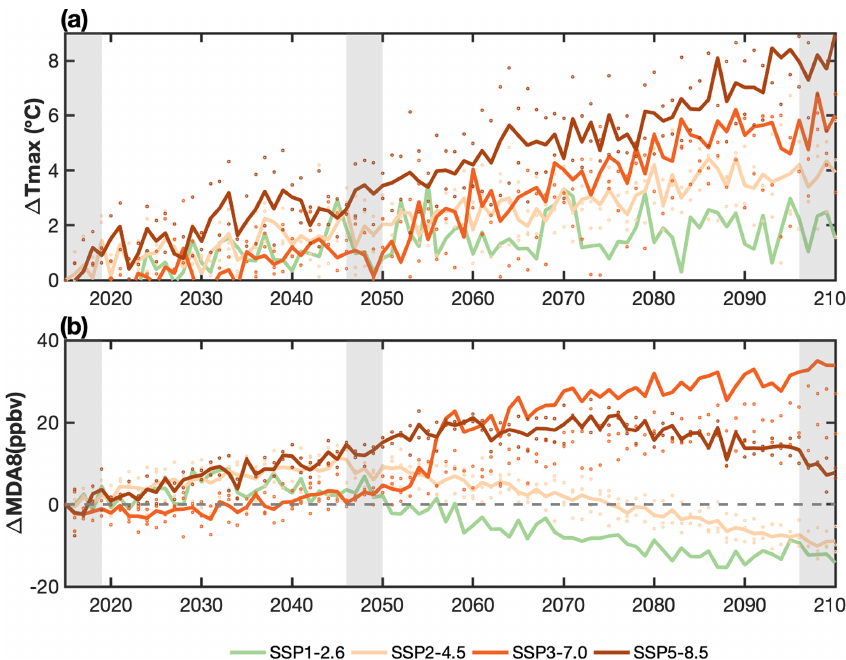
Figure 7. Changes in annual mean (a) Tmax and (b) MDA8 O 3 averaged over NCP (37–41 ◦ N; 114–120 ◦ E) relative to 2015 under SSP1– 2.6, SSP2–4.5, SSP3–7.0, and SSP5–8.5. The colored lines indicate the multi-model ensemble mean for each SSP and the scattered dots with the same color denote results across the available CMIP6 models. The three periods of 2015– 2019, 2046–2050, and 2096–2100 are marked with gray